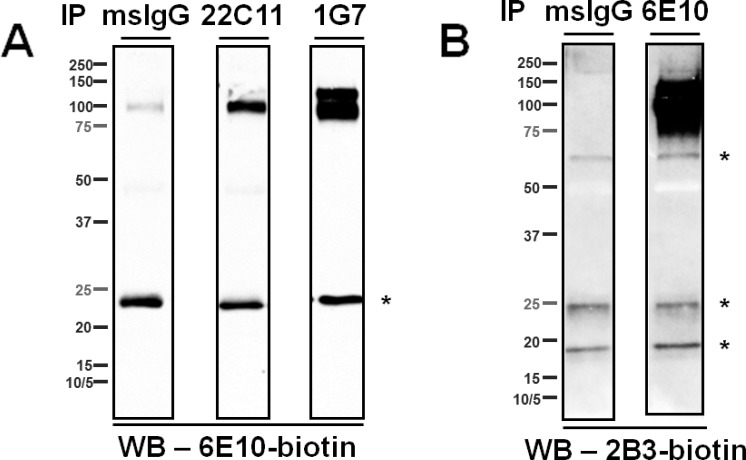
Mapping the N- and C-termini of the ~55- and the ~15- kDa, 6E10-immunoreactive proteins.(A) CSF samples were immunoprecipitated using either 22C11 or 1G7, directed against APP66-81 and APP380-665, respectively, and WB was probed with biotinylated 6E10. Neither antibody captured the ~55- or the ~15- kDa proteins. (B) CSF samples were immunoprecipitated using 6E10, and immunocaptured proteins were detected using biotinylated 2B3, directed against the α-secretase cleavage site of APP. Neither the ~55- nor the ~15- kDa proteins were detected. In both experiments, mouse IgG (msIgG) was used as a negative control capture reagent. * = non-specific bands.